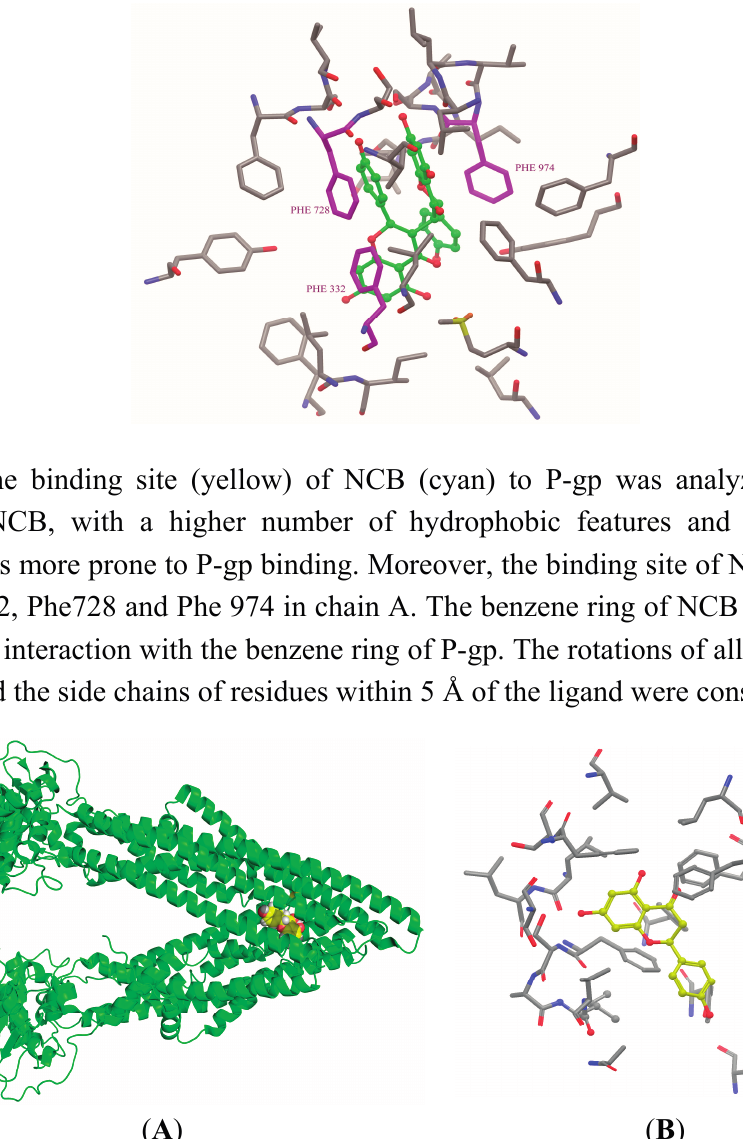
Figure 9. The structure of P-gp (green) and the pocket snapshot of Lig1 (yellow and white) from the molecular docking model ( A ). Additionally, the pocket snapshot is in sticks (B ). The hydrophobic residues contributed primarily to Lig1 binding to P-gp. The rotations of all single bonds of the ligand and the side chains of residues within 5 Å of the ligand were